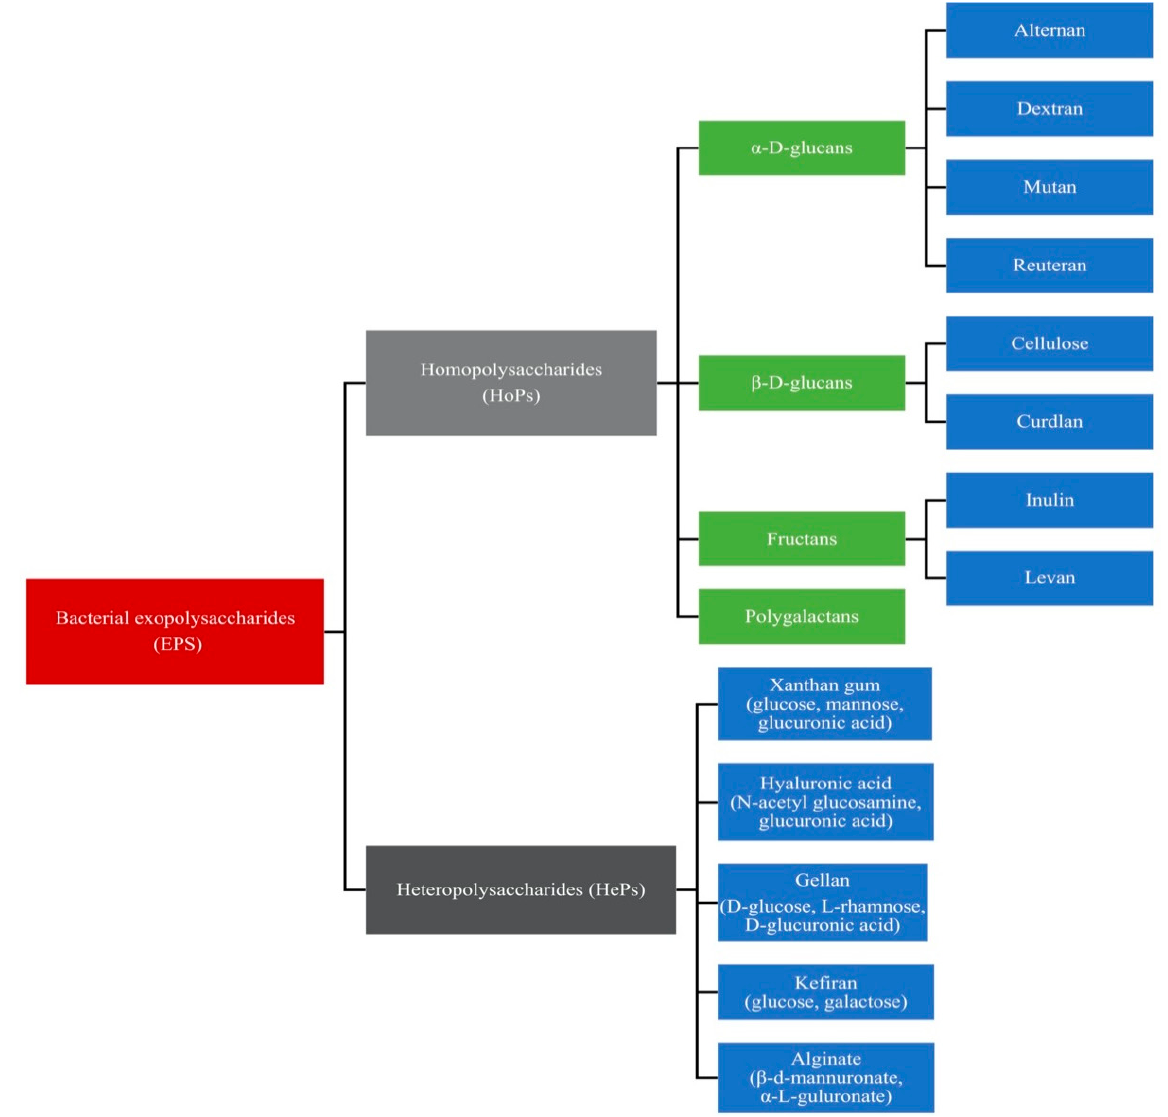
Figure 2. Classification of bacterial exopolysaccharides. Table 1. Example of research on the biomedical applications of bacterial exopolysaccharides (EPSs). Type of EPS Source of